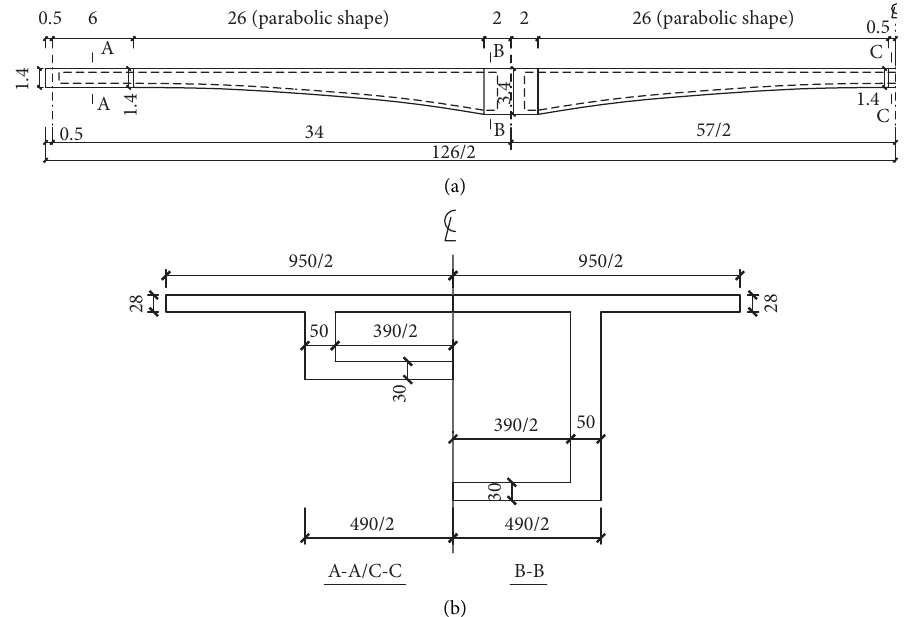
Figure 2: Layout of the analysis bridge. (a) Elevation (unit: m). (b) Typical cross section (unit: